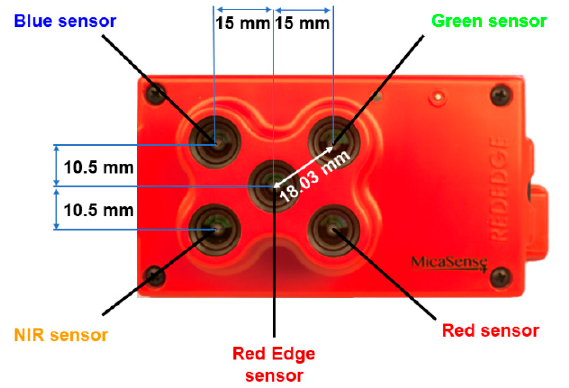
Figure 1. Figure showing the distance between the five sensors of the MicaSense ® RedEdge camera (adapted from www.dronenerds.com).